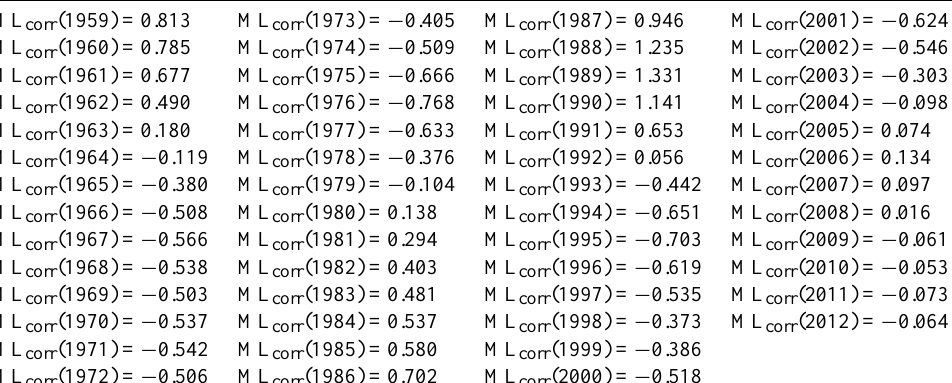
Table C1. Overview of all yearly correction factors used in our XCO 2 model (Sect.